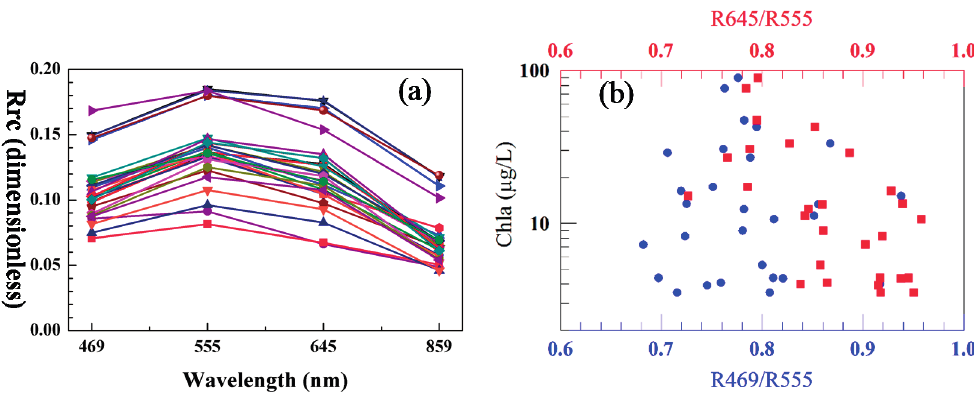
Figure 2. ( a ) MODIS Rrc spectra (469, 555, 645, and 859 nm) corresponding to the